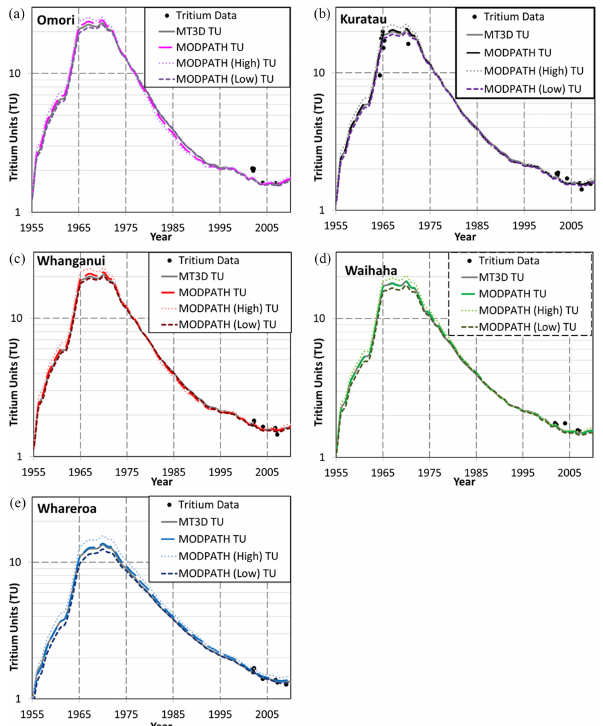
Figure 4. The baseflow tritium concentration calculated by MOD- PATH and MT3DMS (Gusyev et al. 2013) for five watersheds (a–e) .